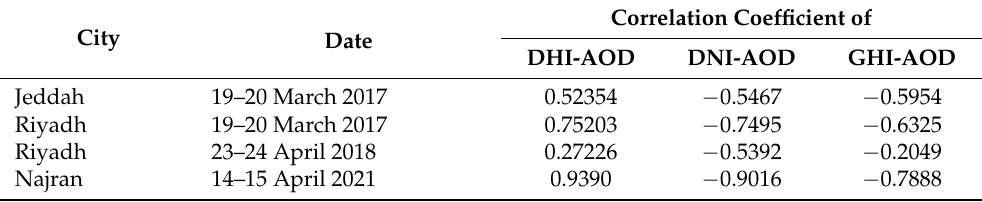
Table 4. Correlation coefficients between either DHI, DNI, or GHI with AOD in (a) Jeddah on